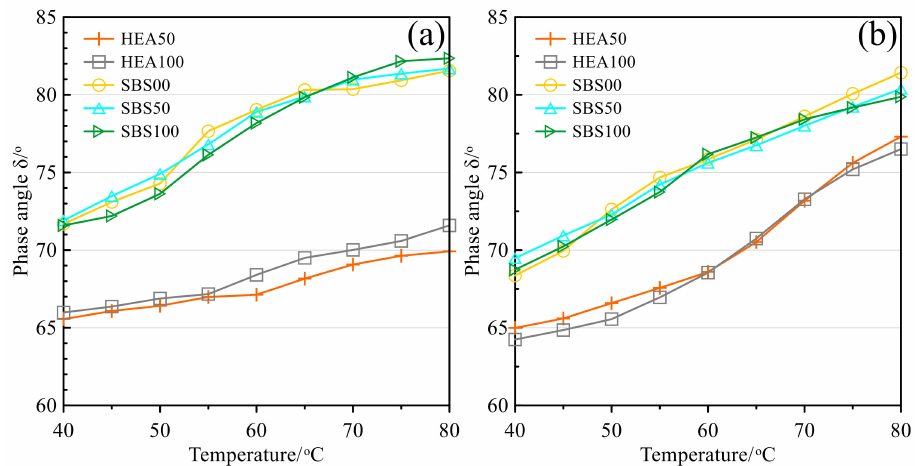
Figure 5. Phase angle: ( a ) Before TFOT; ( b ) After